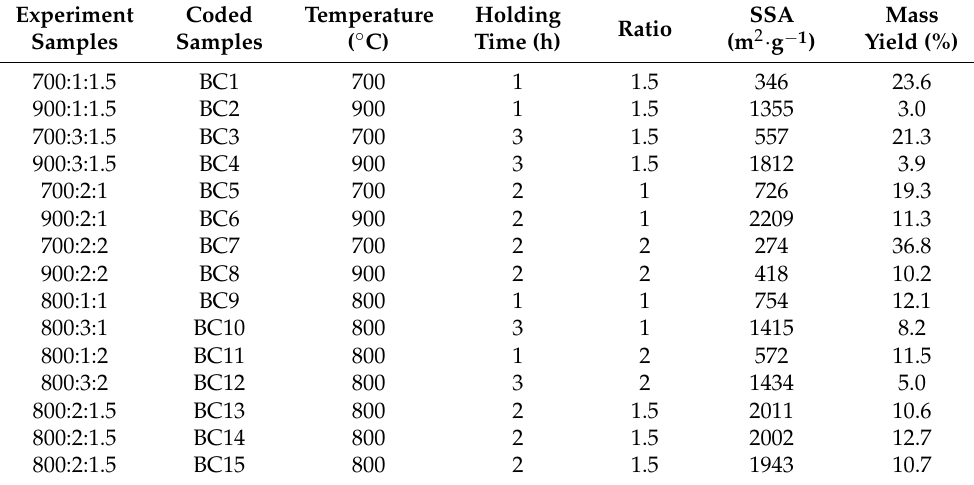
Table 1. BBD matrix of Box–Behnken surface response